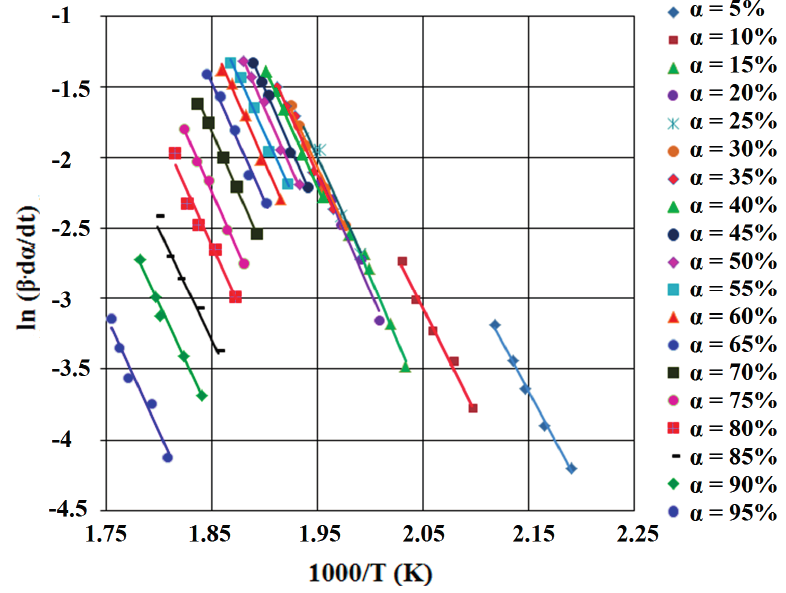
Figure 6. FR (Friedman) diagram, for SB1 derivative.